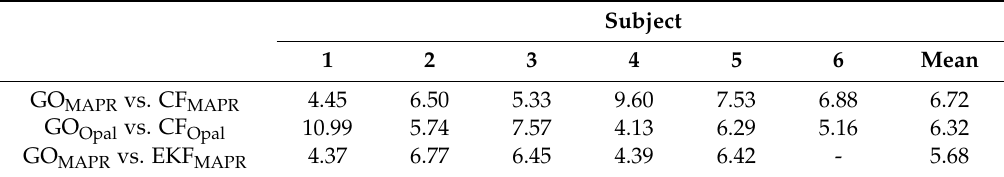
Table 7. RMSE (deg) between CF and GO for each subject. Subject 1 Mean GO MAPR vs. CF MAPR GO Opal vs. CF Opal GO MAPR vs. EKF MAPR